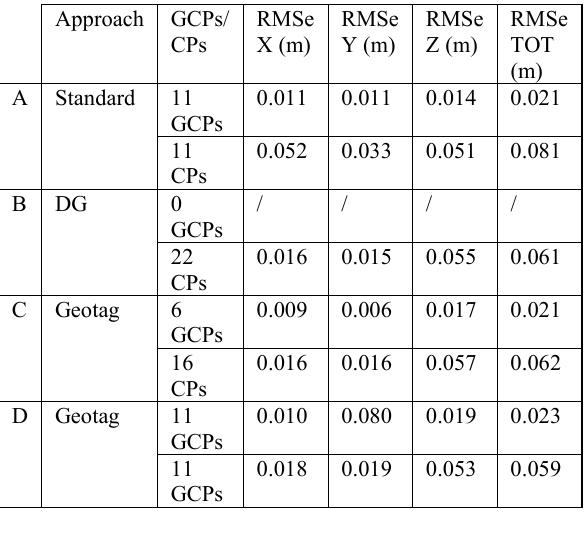
Table 4. RMSe on control points for different processing configuration: Standard approach with 11 GCPs (A),